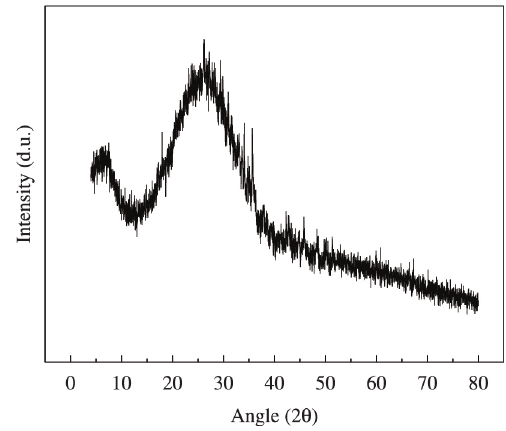
Figure 2. XRD diffractogram of waste